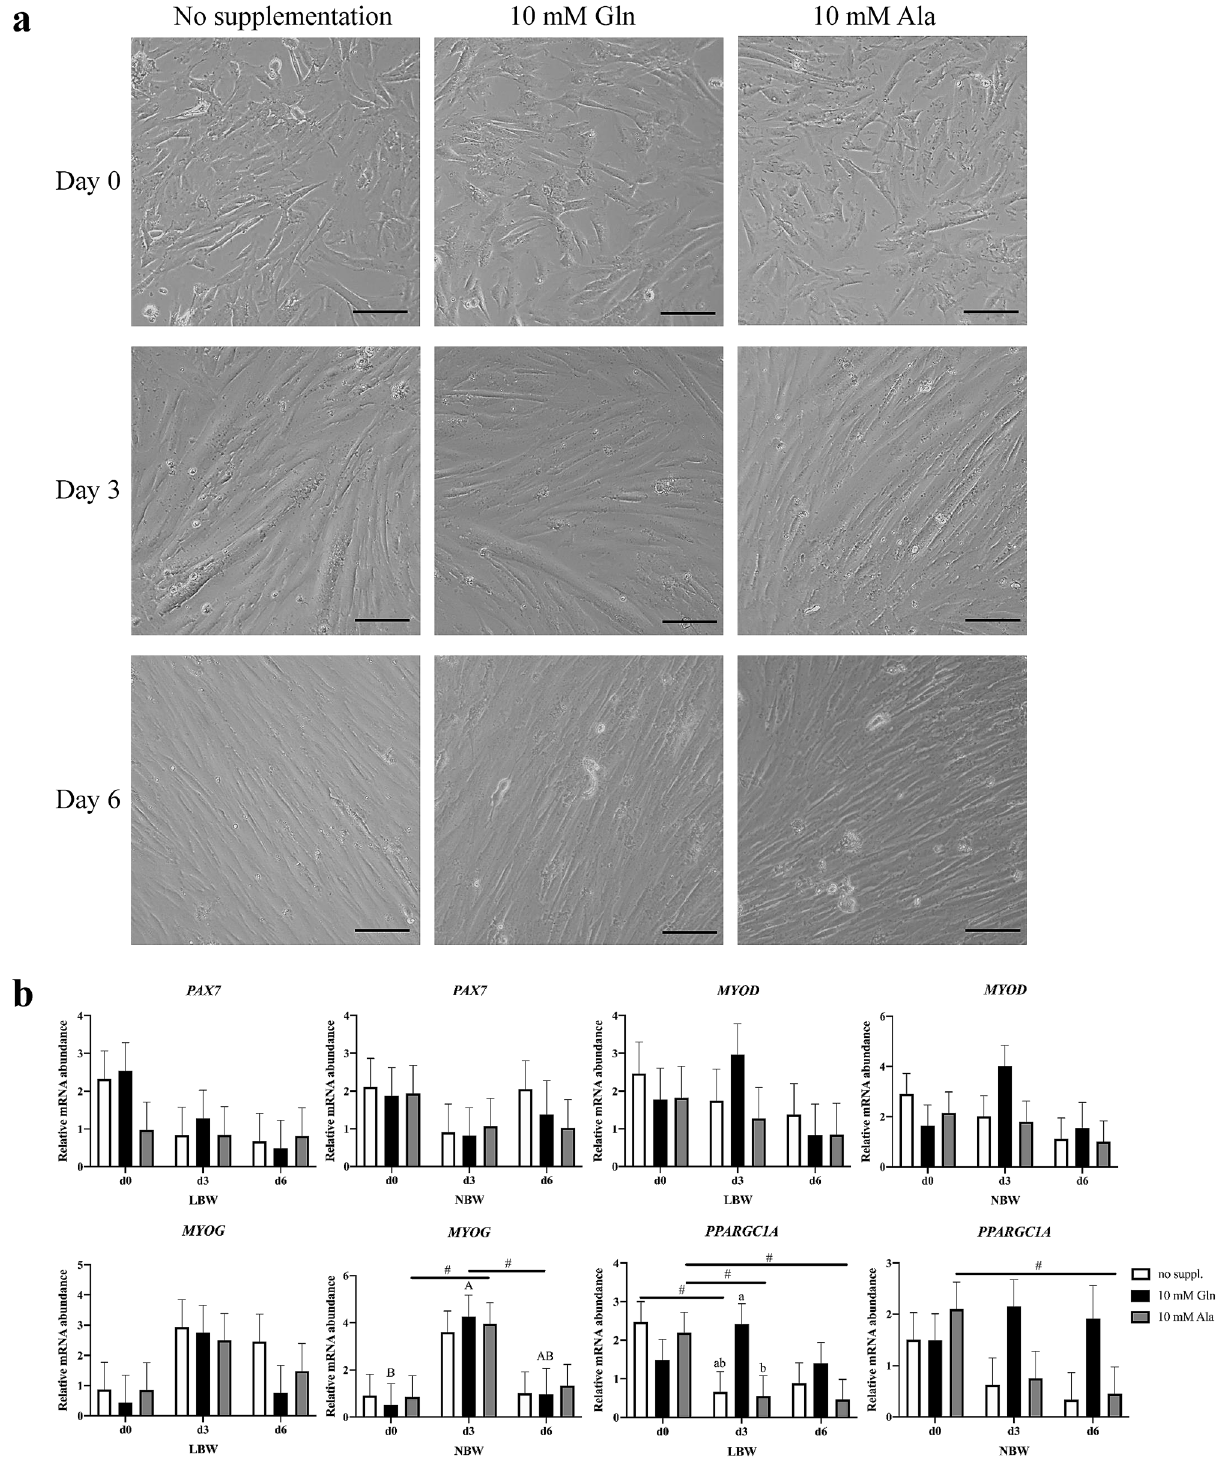
Figure 6. Expression of muscle growth-related genes in differentiating porcine myogenic cells. ( a ) Representative microscopic images of cells of the same sample at day 0 (day of differentiation induction), day 3 and day 6 without supplementation or with 10 mM Gln or Ala. Scale bars represent 200 µm. ( b ) Relative mRNA abundances of PAX7 , MYOD , MYOG and PPARGC1A in myogenic cells from low (LBW) or normal birth weight (NBW) piglets at day 0, day 3 and day 6 after induction of differentiation. Values were normalized to YHWAZ and PPIA expression and are presented as LSmeans and SE (n = 3 per group). Different lowercase letters indicate significant differences among groups within the same time point, different uppercase letters indicate significant differences ( p ≤ 0.05, Tukey–Kramer test) and # trend for differences (0.5 < p ≤ 0.1) among different time